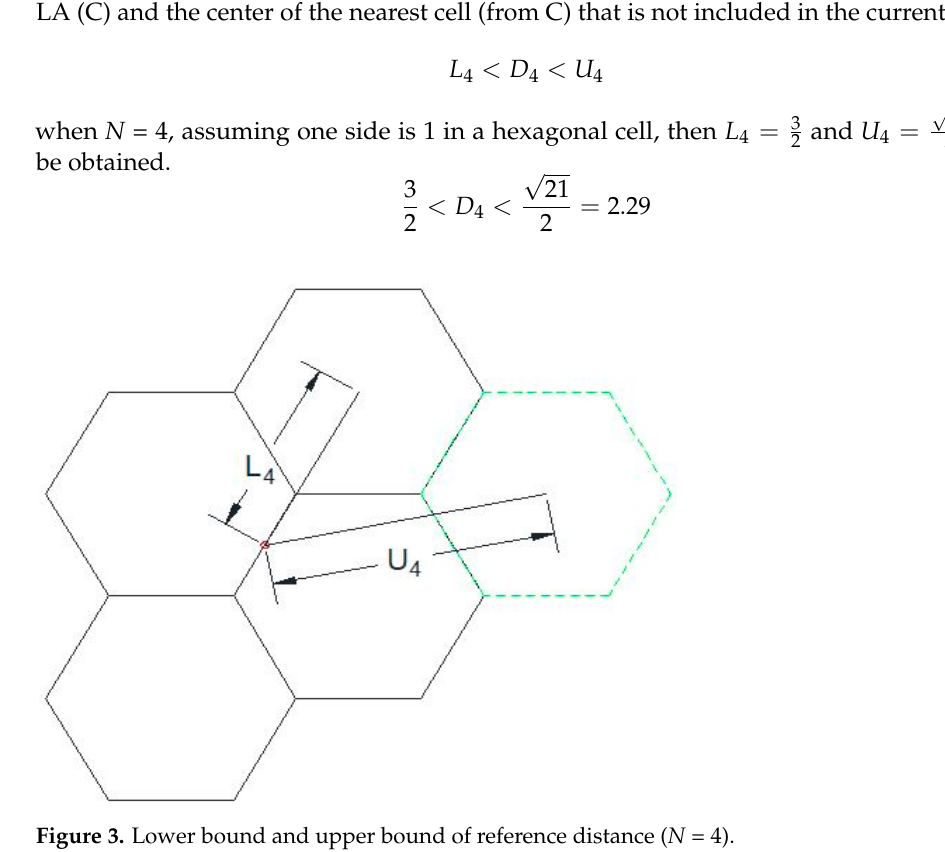
Figure 4. Center of location area, lower bound, and upper bound of reference distance ( N = 8). In a ring-by-ring DBR, if N = 8, location registration cannot be defined. If N = 8, the UE calculates the distance between the center of the entered cell and the newly defined center of the LA (C). If N = 8, the center of the LA, C, is defined as the midpoint between the center of the cell 0 and the vertex (of cell 0) directed for the farthest cell (4). If the